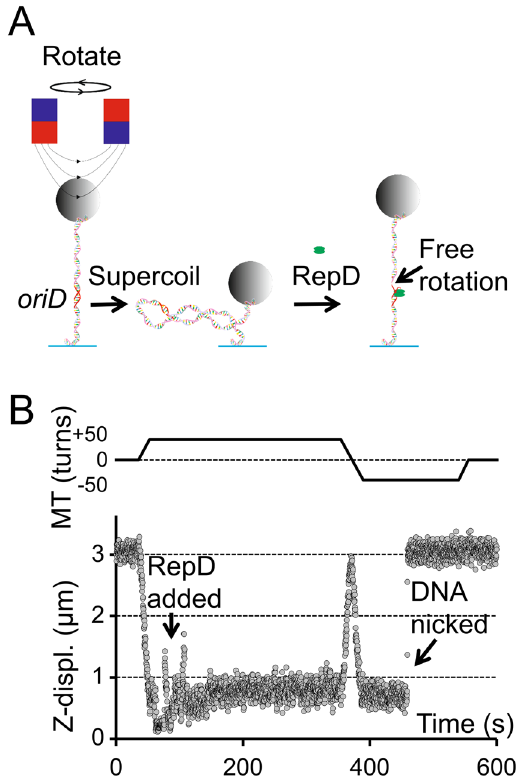
Figure 2. Magnetic tweezers RepD nicking assay. ( A ) A 1 μ m diameter, paramagnetic bead is attached by multiple biotin-streptavidin linkages to one end of a dsDNA (4 kb or 10 kb) molecule that has the initiation site, oriD , within its central region. Multiple digoxigenin-anti-digoxigenin linkages attach the other end to a glass microscope coverslip. Application of a magnetic field, generated by a pair of permanent magnets, causes the bead to rise from the microscope coverslip surface, extending the DNA molecule. Rotation of the magnetic field causes bead rotation and DNA supercoiling. At low force, the dsDNA first becomes twisted and then undergoes plectoneme formation (DNA writhe) resulting in reduction in DNA end-to-end length and bead motion towards the coverslip surface. When RepD nicks the DNA, supercoiling is relaxed and the bead moves rapidly upwards, towards its extended length. ( B ) The upper trace shows rotation of the magnetic tweezers (MT) and the lower trace shows bead displacement relative to its rest height plotted as a function of time. At the start of the experiment (t = 50 s), the DNA is supercoiled positively by 50 turns, increasing its super-helical density, σ , by (50 × (10.5/10 kb)) = + 5% which causes plectoneme formation and bead height to reduce. RepD (1 nM) is then flowed into the experimental chamber (down-arrow, t = 80 s) and after 250 s the DNA remains intact and supercoiled. The magnetic tweezers are then rotated counter-clockwise by 100 turns (at t = 350 s) so that the DNA is then negatively supercoiled by − 50 turns ( σ = − 5%). After a stochastic delay (here, ~50 s) the DNA is nicked (diagonal arrow) and the bead moves rapidly back to rest height. After a further 100 s (at t ~ 525 s), rotation of the magnetic tweezers causes the magnetic bead to rotate but no longer causes the DNA to become supercoiled. The applied force due to the magnetic field was 0.4 pN and temperature was 23 °C.